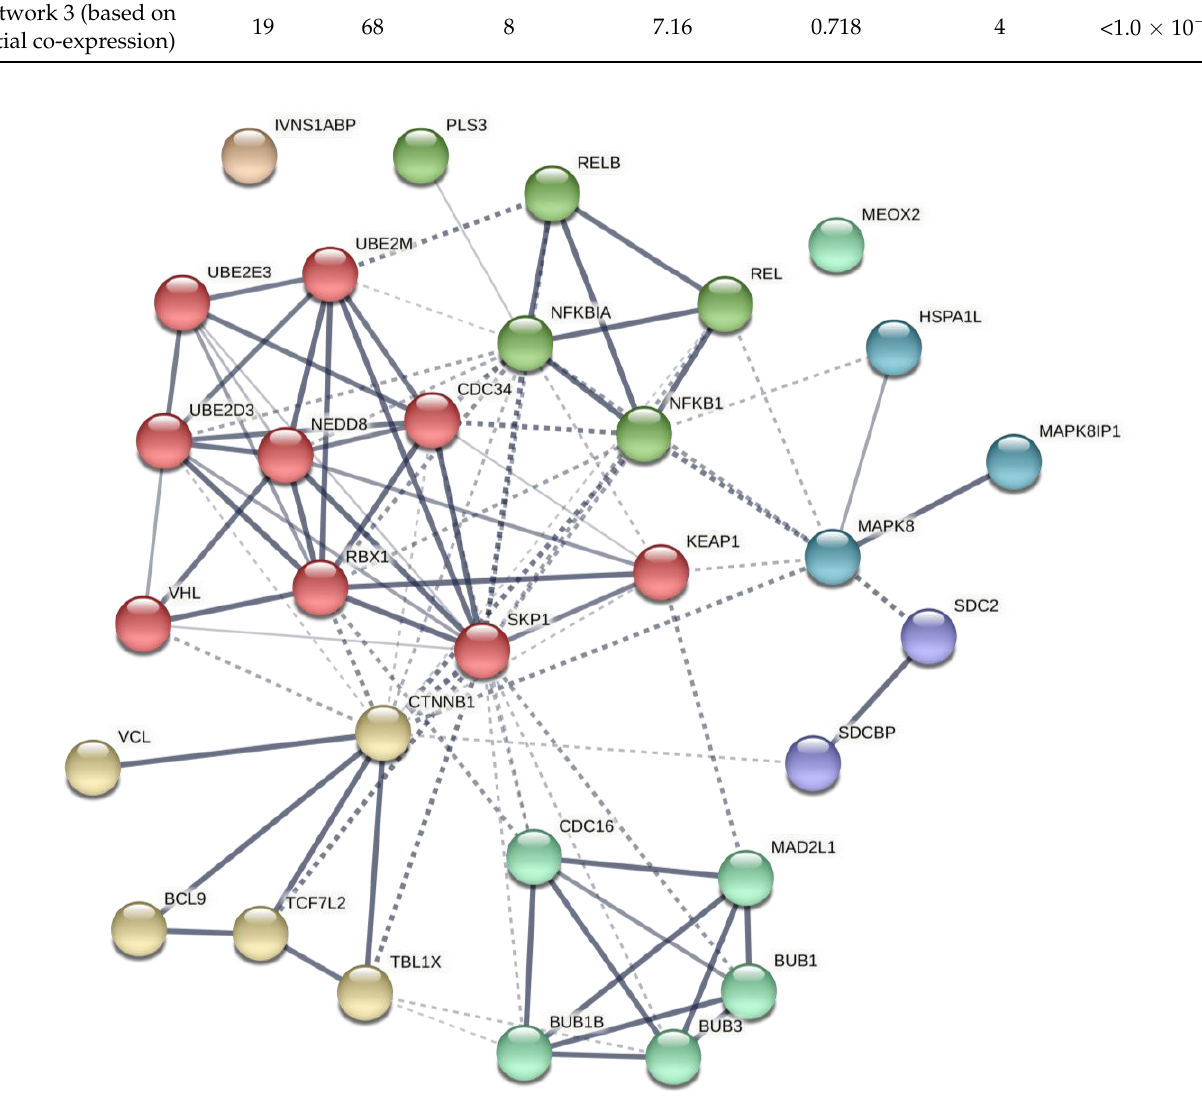
Figure 4. Network 1: Interaction network based on initial predicted PPIN. This network was reconstructed by 12 genes with the highest degree of predicted regulatory miR-499 PPIN as inputs. Each cluster is illustrated with a different color. Edges represent protein–protein associations. Chromatic edges indicate highest (0.9), high (0.7), medium (0.4), and low (0.15) confidence. Inter-cluster edges are shown with dashed lines. PPIN, protein-protein interaction network; miR, microRNA.